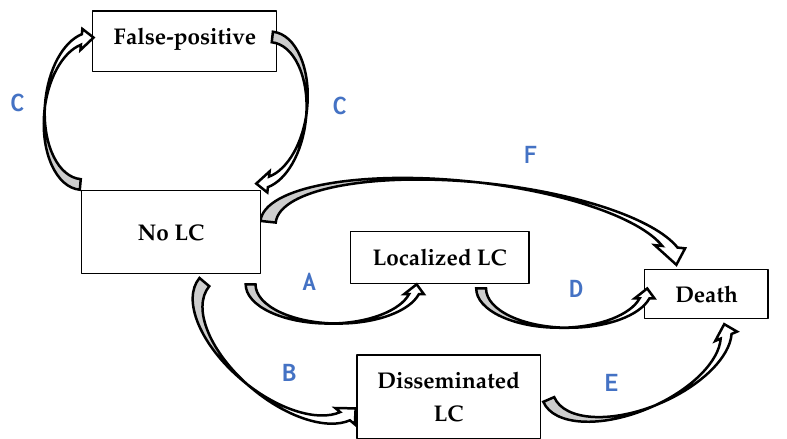
Figure 1. Structure of the Markov model (cycle = 1 year). A: Probability of localized (stage I and II) lung cancers (LCs) with (8) or without screening (23). B: Probability of disseminated (stage III and IV) LCs with (8) or without screening (23). C: Rate of false-positive computed-tomography scan findings (9). D: Probability of death attributable to localized LCs (23). E: Probability of death attributable to disseminated LCs (23). F: Probability of death without LC (22).